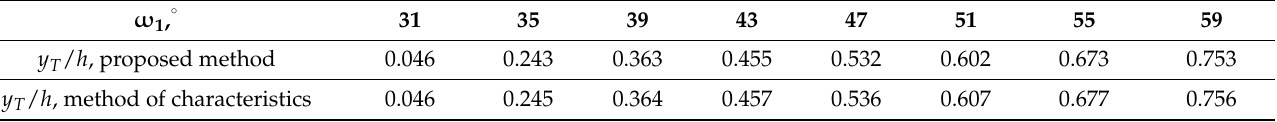
Table 1. Comparison of analytical method with numerical results.